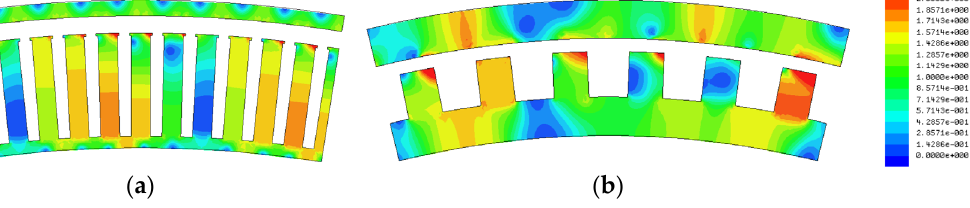
Figure 12. Flux density distribution at rated conditions ( a ) reference model, ( b ) designed SPMVG.